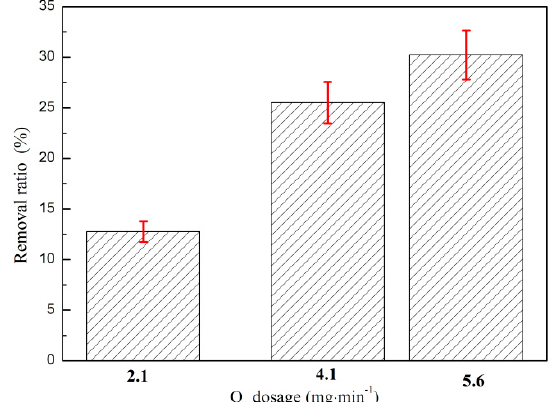
Figure 3. Effect of different O 3 dosage rate on coking wastewater treatment by O 3 catalytic